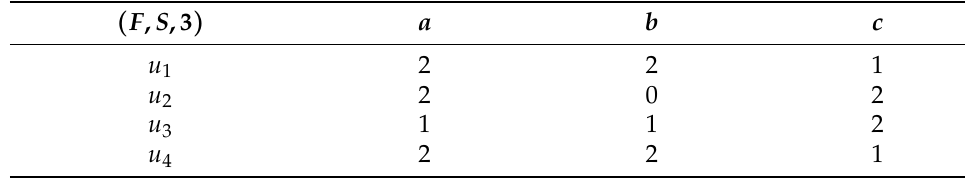
Table 5. The 3-Soft Set of ( F , S ,3 ) .